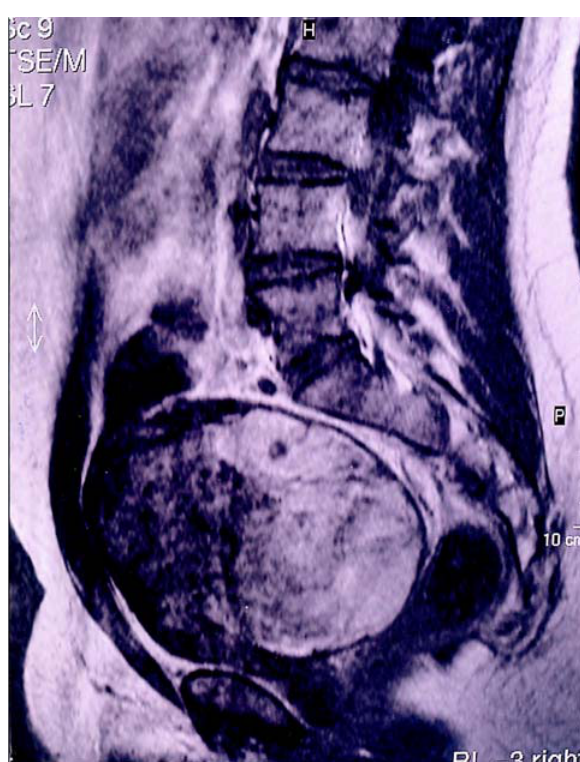
Figure 1 – Magnetic resonance imaging of the pelvis showing seminal vesicle tumor.